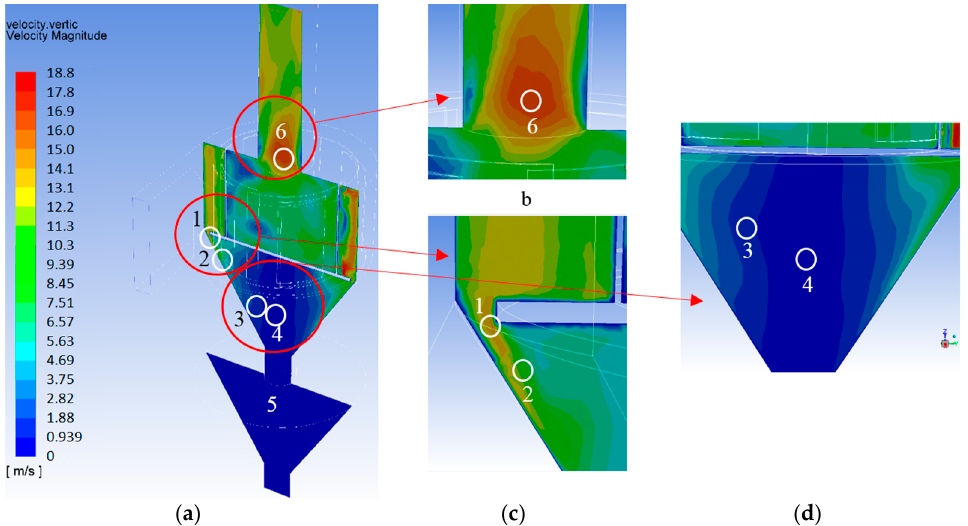
Figure 6. The vertical isoline and vector gas flow distribution in the single-inlet cyclone separator: ( a ) is the vertical section, ( b ) is the air flow outlet, ( c ) is the joint of the separation chamber and the hopper, and the peripheral slit, and ( d ) is the cone-shaped top of the hopper, the areas below the external oblong peripheral slits (point 1), in the cyclone separator’s upper hopper near the wall (point 2) in the central zone (point 3), in the axis of the upper cone-shaped part of the hopper (point 4), in the lower cone-shaped part of the hopper (point 5), in the upper part of the separation chamber, along the central axis of the treatment device (point 6).